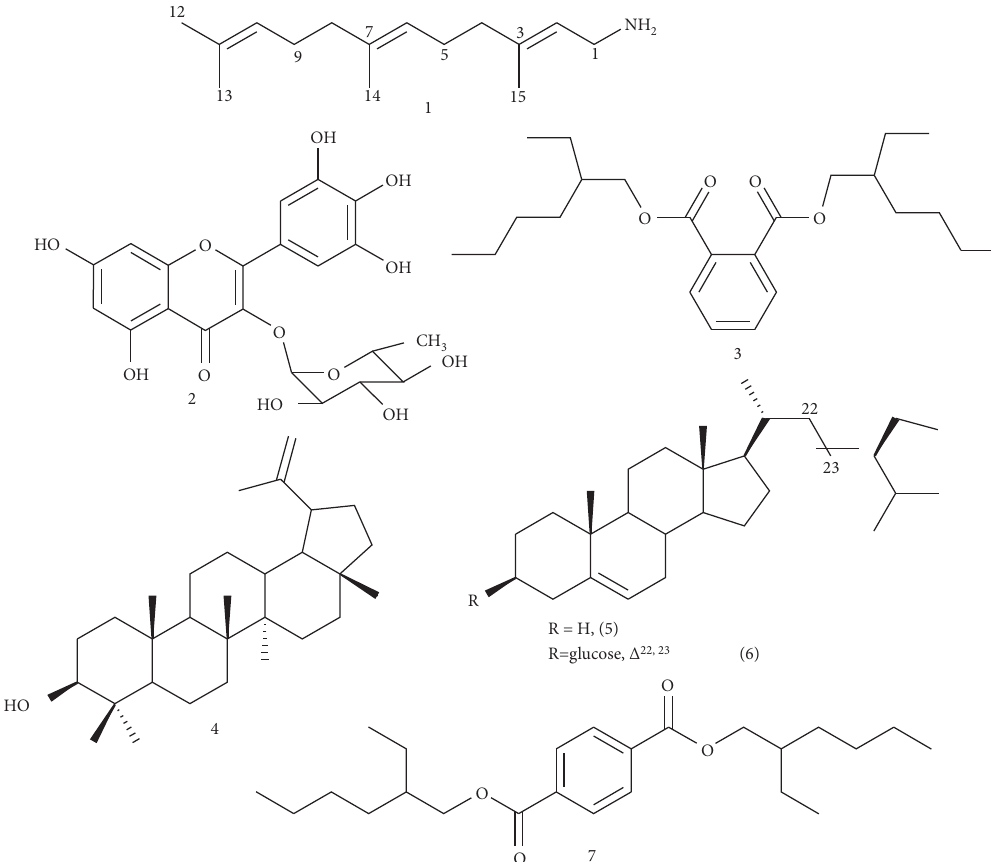
Figure 1: Structure of isolated compounds